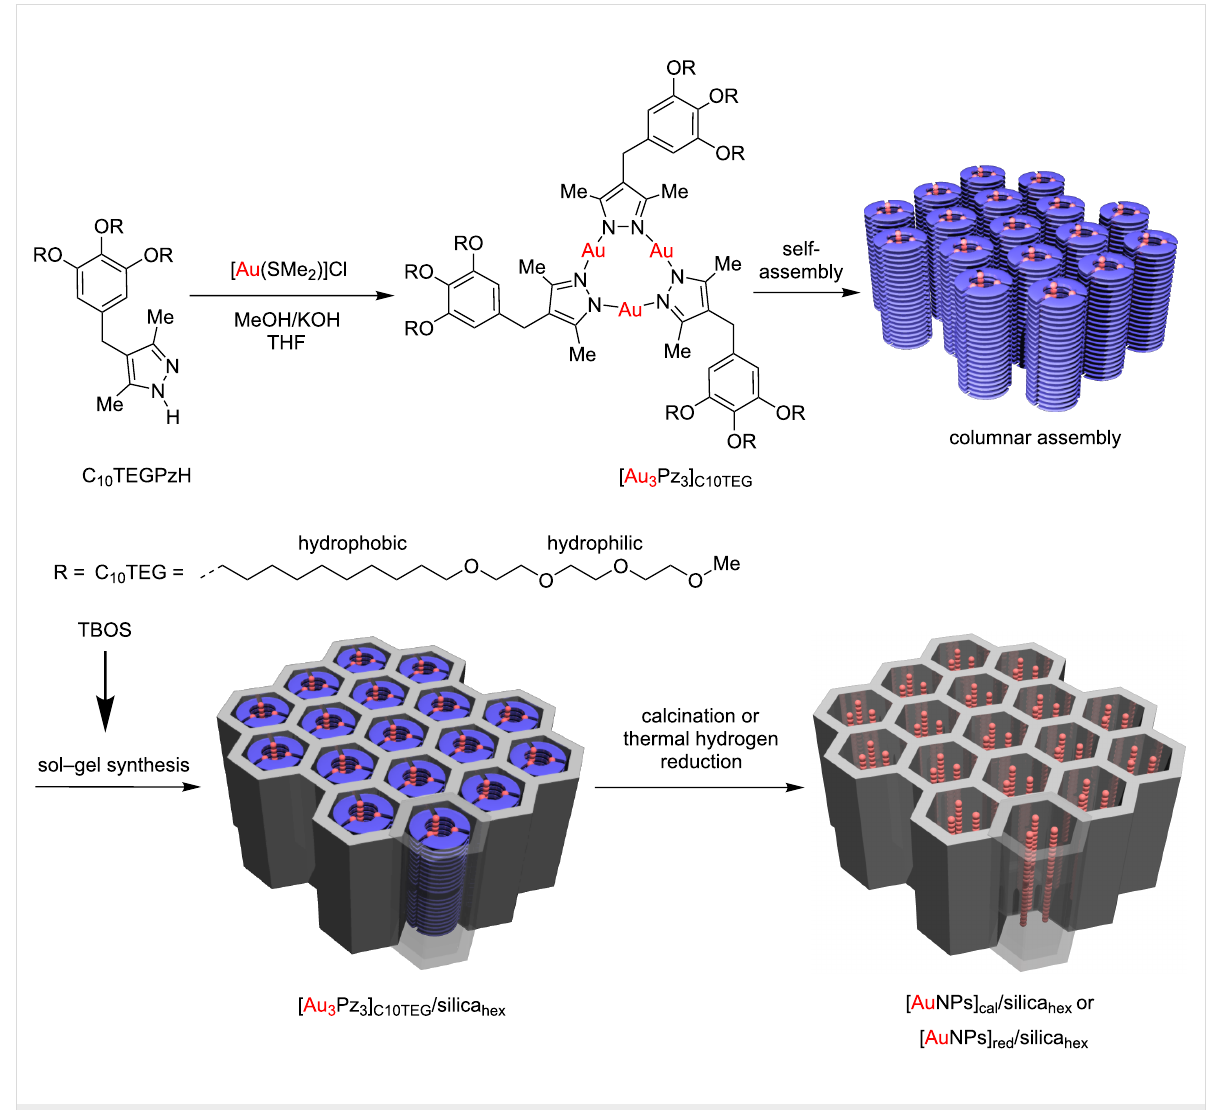
Figure 1: Schematic for the synthesis of [Au 3 Pz 3 ] C10TEG from C 10 TEGPzH and the fabrication of [Au 3 Pz 3 ] C10TEG /silica hex through a sol–gel synthe- sis with tetrabutyl orthosilicate (TBOS) as a silica source, followed by the synthesis of [AuNPs] cal /silica hex or [AuNPs] red /silica hex by calcination or thermal hydrogen reduction. The synthetic scheme is adapted from